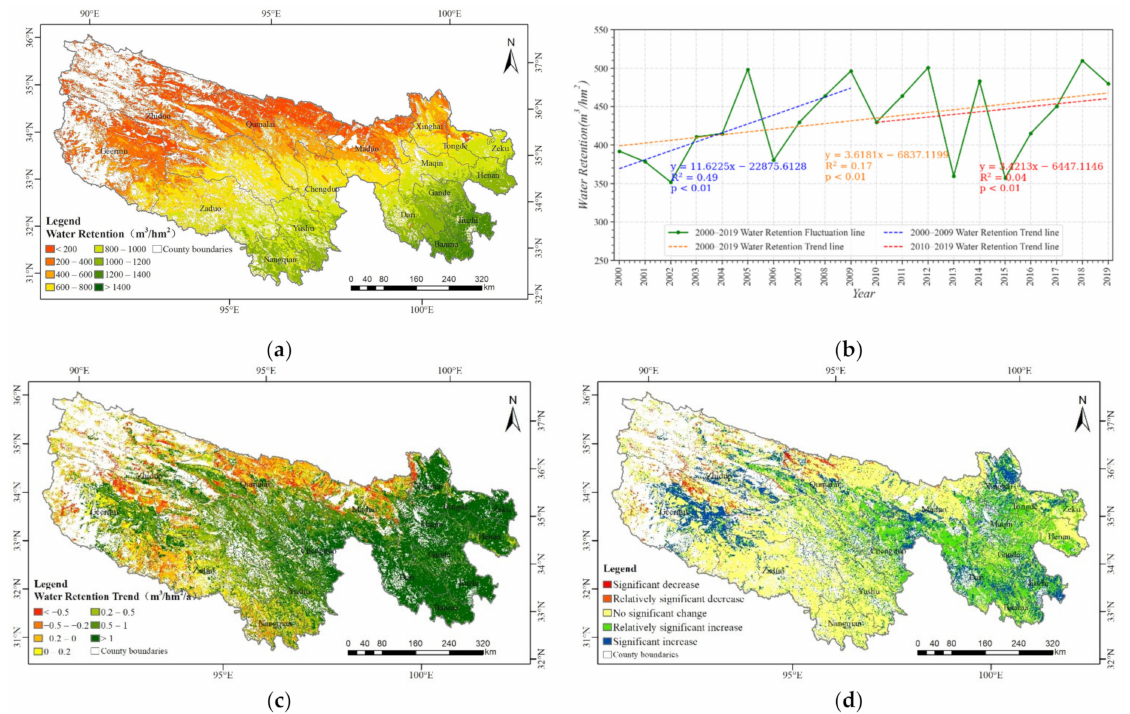
Figure 6. Spatial distribution of average annual water retention ( a ), inter-annual changes ( b ), change trend ( c ), and significance ( d ) of forest and grass ecosystems in the TRHR from 2000 to 2019. At the pixel scale, there were significant spatial differences in the interannual variation of water retention per unit area of the TRHR forest–grass ecosystem (Figure 6c). The water